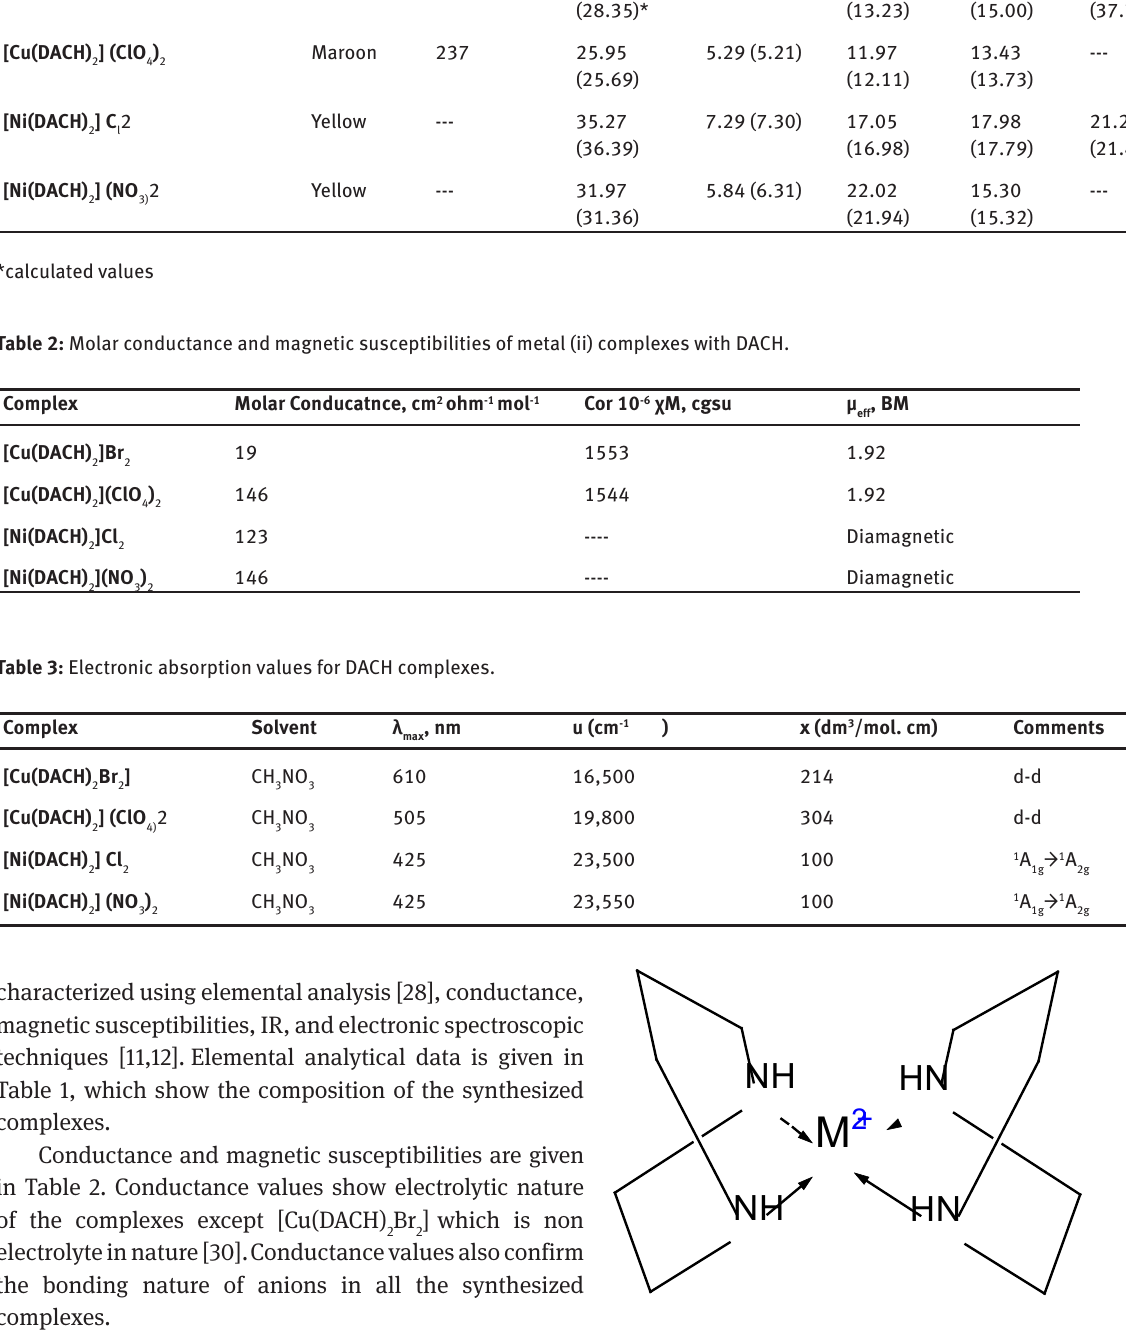
Figure 2: Structure of DACH complexes.